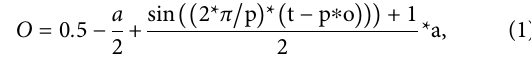
Frontiers in Robotics and AI |